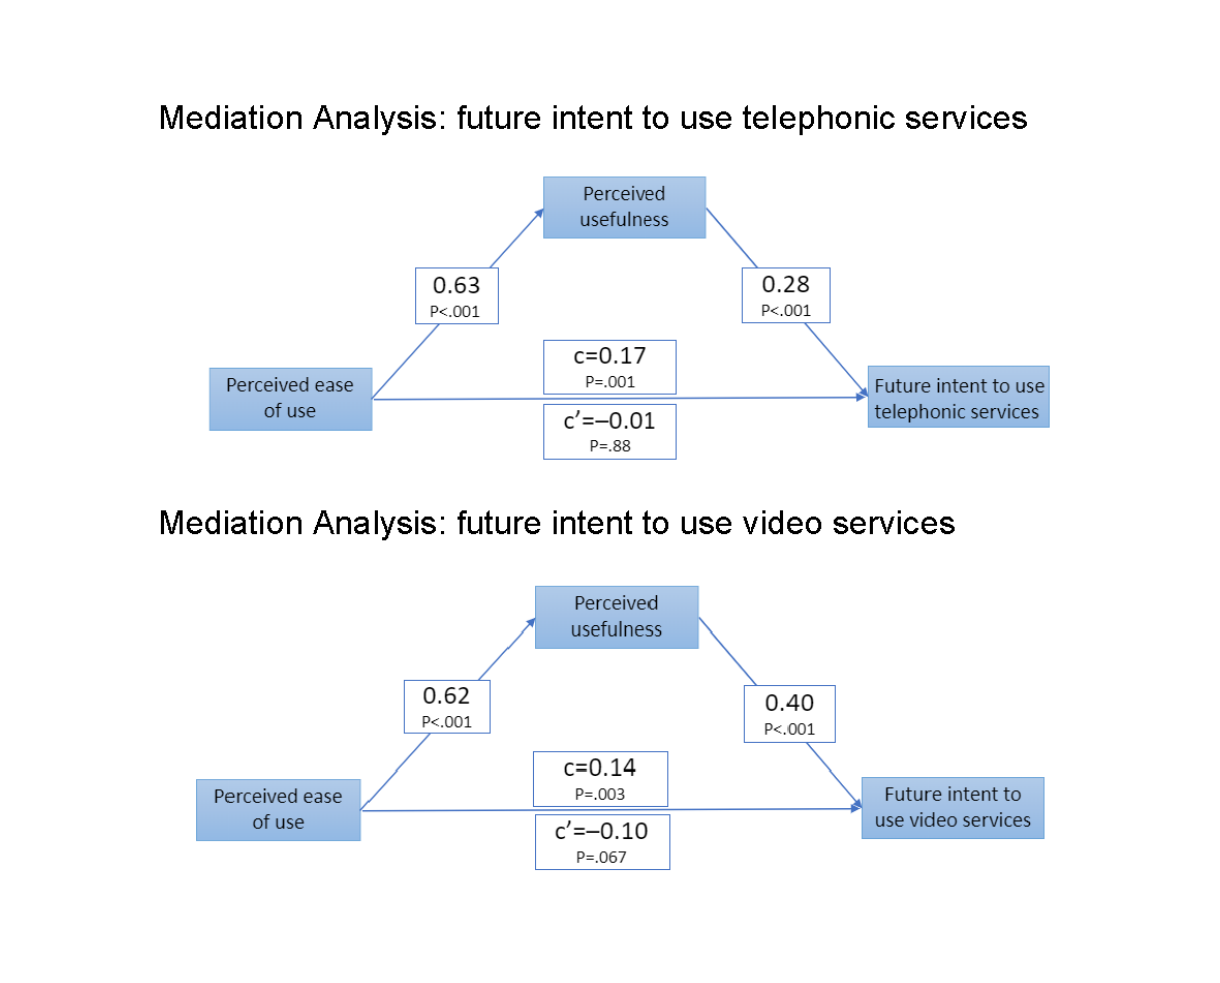
Figure 2. Technology acceptance model for telephonic services and video substance use disorder